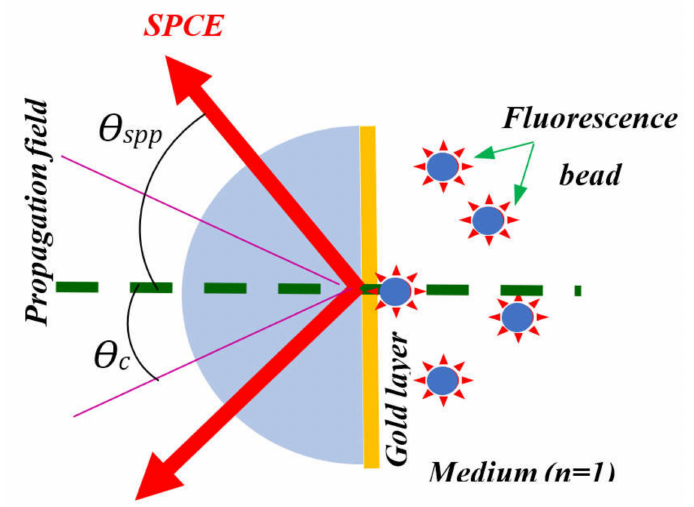
Figure 3. Demonstration of surface plasmon-coupled emission (SPCE).